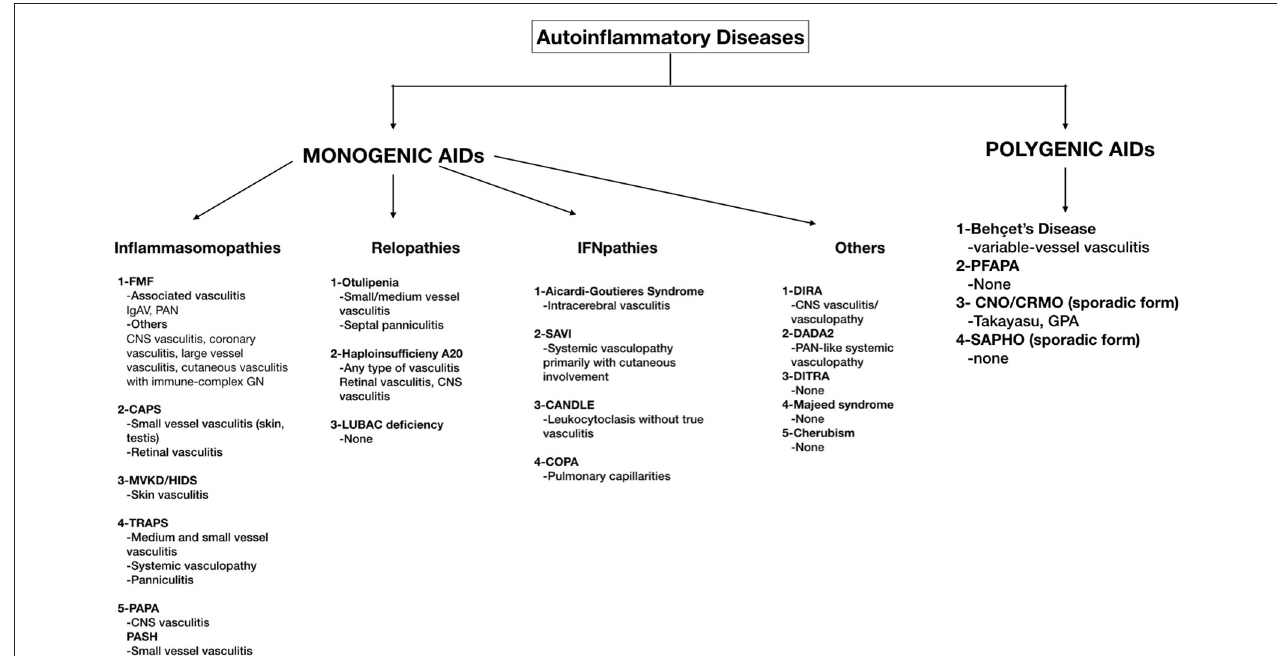
FIGURE 1 | A schema of monogenic and polygenic autoinflammatory diseases with vasculitic features. FMF, Familial Mediterranean Fever; IgAV, Immunoglobulin A vasculitis; PAN, Polyarteritis Nodosa; CNS, Central Nervous System; GN, Glomerulonephritis; CAPS, Cryopyrin Associated Periodic Fever Syndrome; MKD/HIDS, Mevalonate kinase deficiency/Hyperimmunoglobulin D syndrome; TRAPS, Tumor Necrosis Factor Receptor–Associated Periodic Syndrome; PAPA, Pyogenic Arthritis, Pyoderma gangrenosum; PASH, Acne Pyoderma gangrenosum; Acne, Hidradenitis Supurativa; LUBAC, Linear ubiquitin chain assembly complex; SAVI, STING-associated vasculopathy with onset in infancy; CANDLE, Chronic atypical neutrophilic dermatosis with lipodystrophy and elevated temperature syndrome; DIRA, Deficiency of Interleukin-1 Receptor Antagonist; DADA2, Deficiency of Adenosine Deaminase-2 (DADA2); DITRA, deficiency of the interleukin-36 receptor antagonist; PFAPA, periodic fevers with aphthous stomatitis, pharyngitis, and adenitis; CNO/CRMO, Chronic nonbacterial osteomyelitis/Chronic recurrent multifocal osteomyelitis; SAPHO, Synovitis, Acne, Pustulosis, Hyperostosis, and